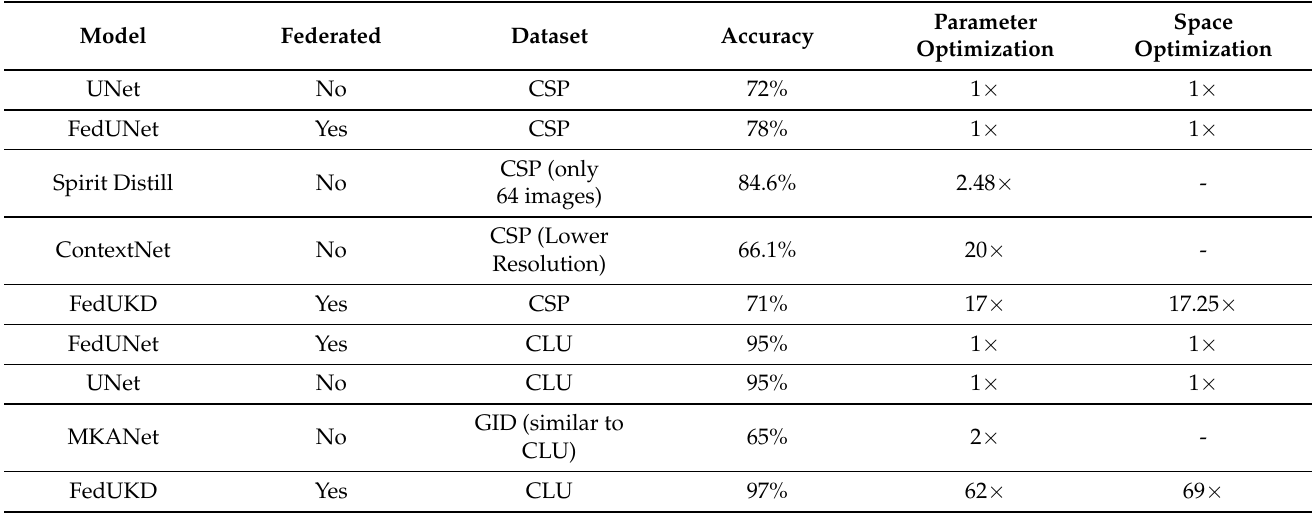
Table 1. Model performance: summary of